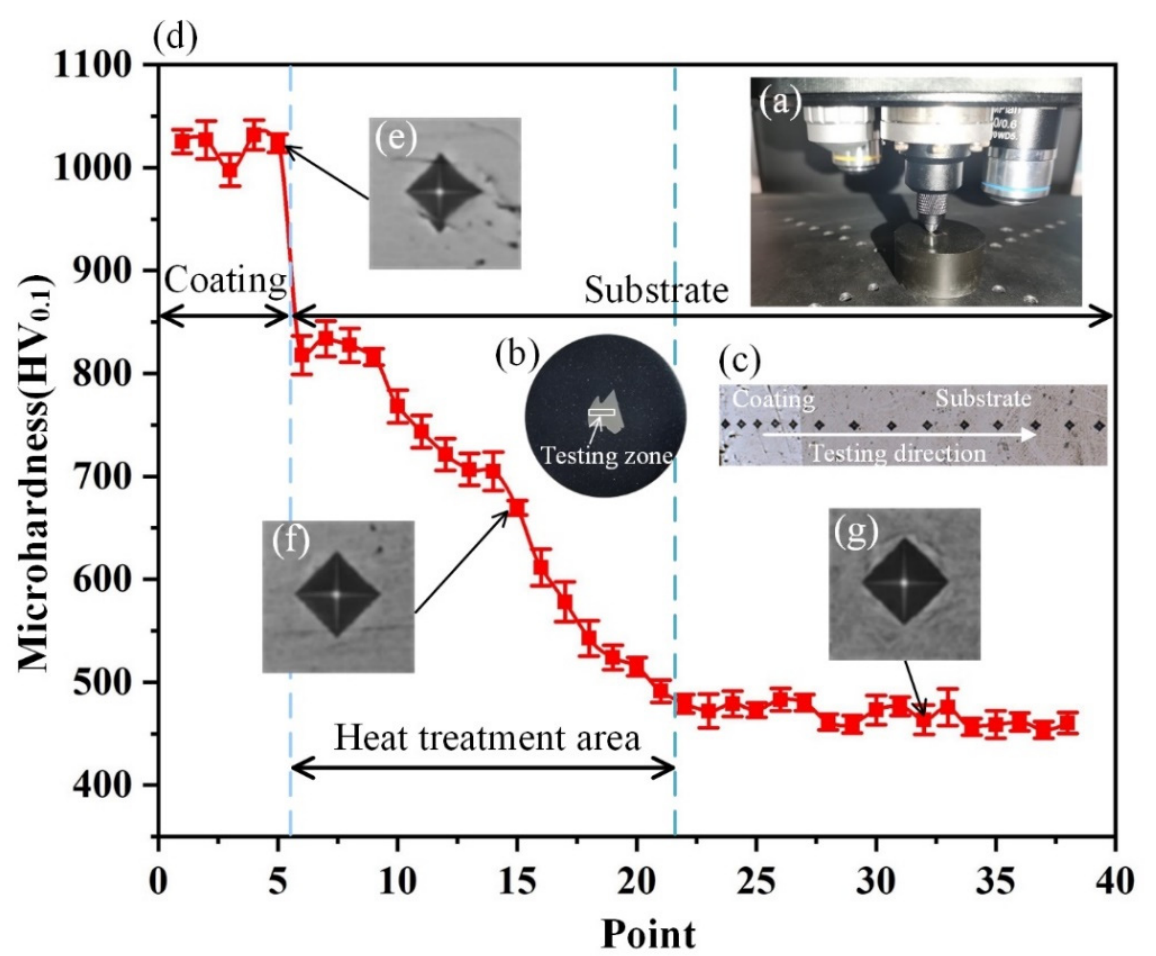
Figure 4. Coating and substrate hardness testing: ( a ) first wire cutting process; ( b ) testing zone; ( c ) testing direction; ( d ) coating to substrate hardness change curve; ( e ) coating hardness test indenta- tion; ( f ) heat treatment area hardness test indentation; and ( g ) substrate hardness test indentation.